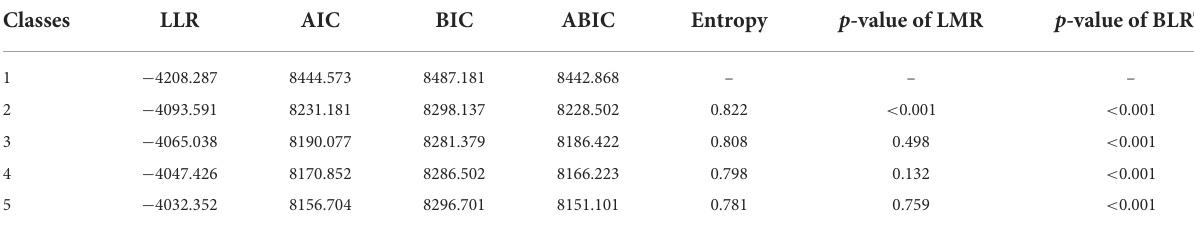
TABLE 1 Model estimations of latent profile analysis based on MCCB cognitive domains.